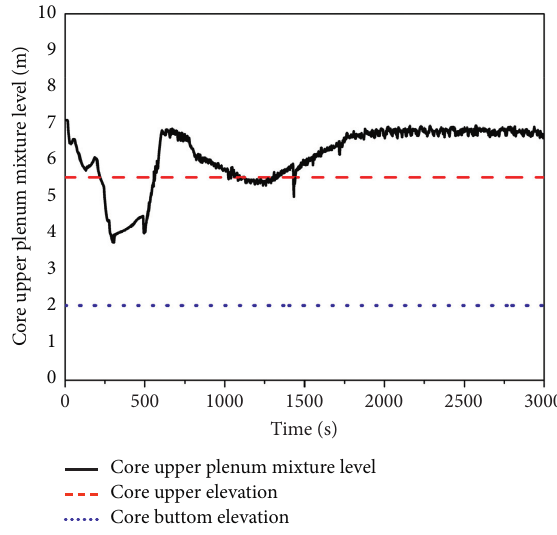
Figure 24: DEDVI line break reactor water level.